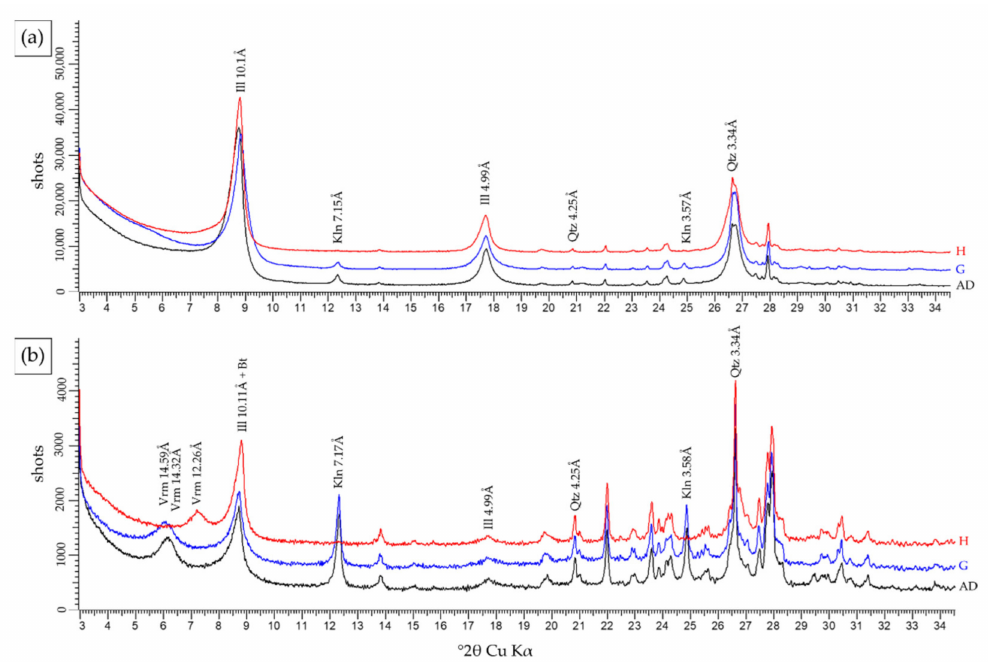
Figure 3. Two examples of XRD patterns obtained for the clay fraction <2 µ m in air-dried (AD–dark), after glycol solvation (G-blue) and heated (H-red) conditions for the NH granite, which were not identified in the fresh granite described by [19], and showing different clay compositions. ( a ) Illite, kaolinite, and quartz. ( b ) Vermiculite, illite, kaolinite, and